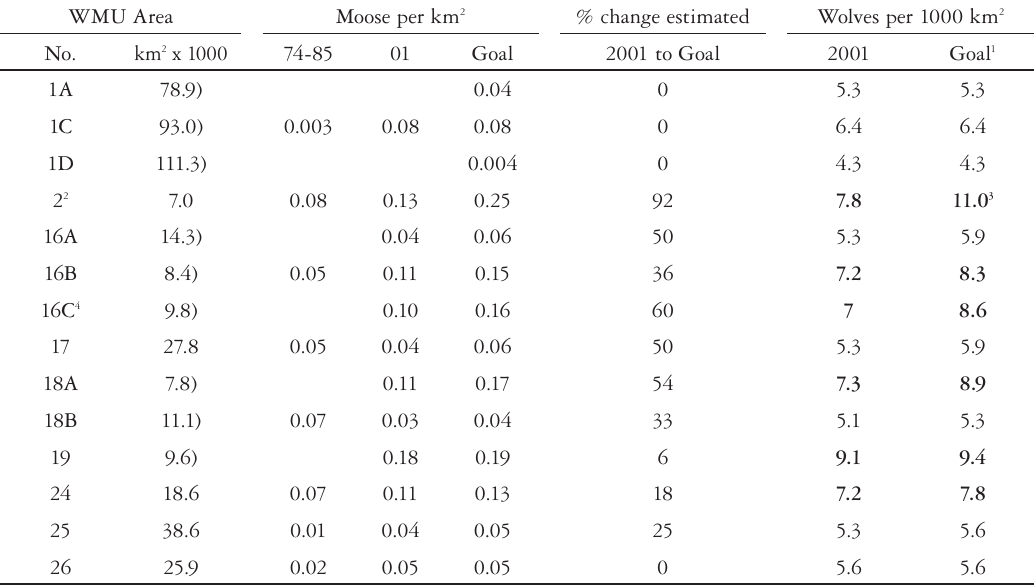
Table 1. Comparison of moose densities in Ontario 1974-85 vs . 2001 and management goals for Ontario Wildlife Management Units as projected in 2001 that still have a continuous caribou distribution (Fig. 3). Files pro- vided the author from OMNR files, Thunder Bay office in 2006 5